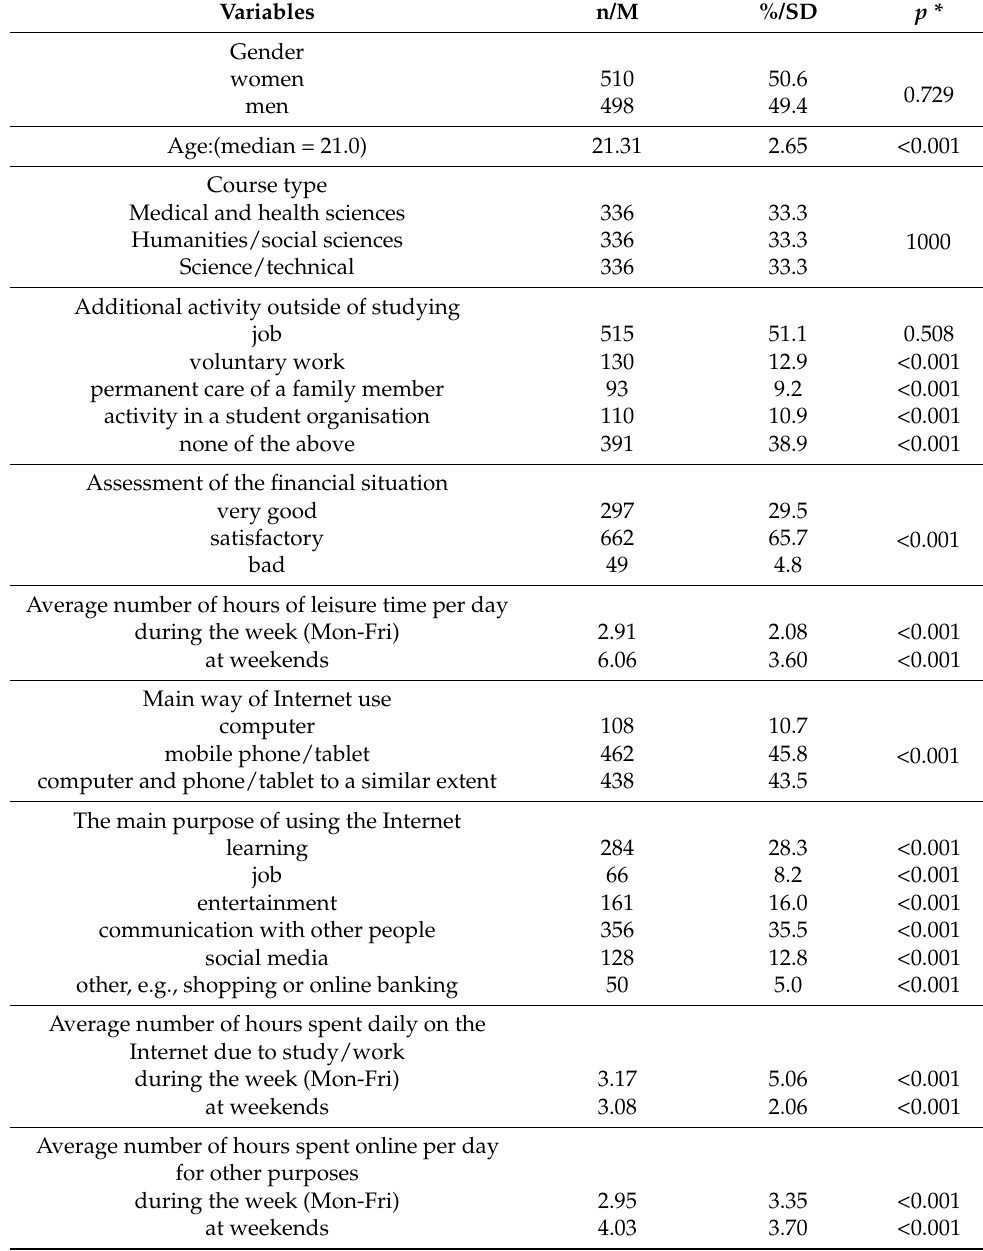
Table 1. Sociodemographics and Internet use